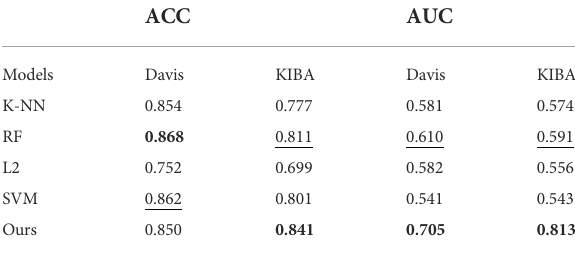
TABLE 3 Multi-classi fi cation results obtained on the Davis and KIBA